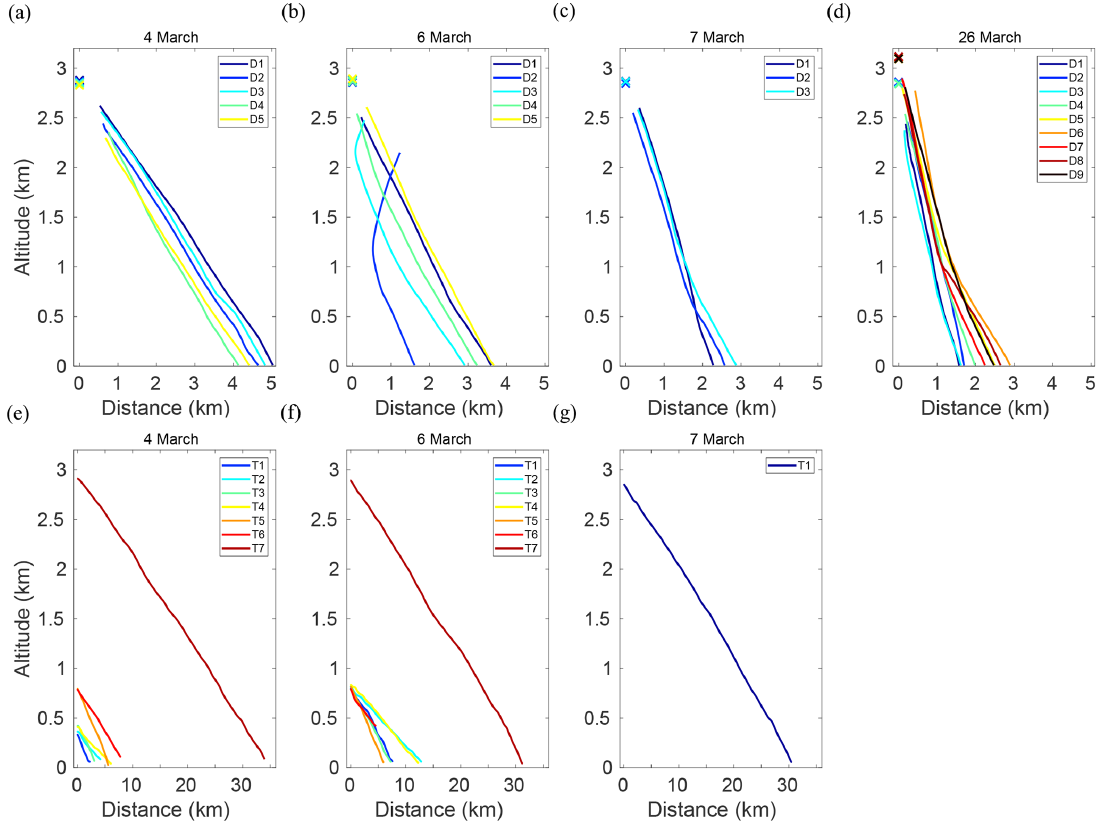
Figure 5. Horizontal drift distances of the dropsondes (a–d) and distances flown by the aircraft during ascents and descents (e–g) . Distances are calculated with respect to the uppermost measurement point. For the dropsondes, this information is missing for the uppermost layer (see text), and coloured crosses refer to the dropsondes’ release altitudes derived via